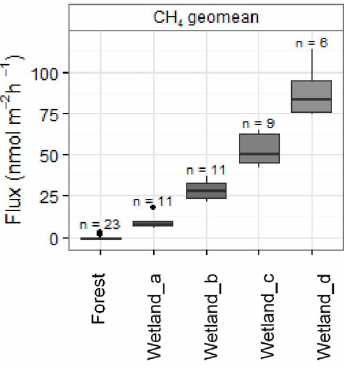
Figure 5. Chambers clustered based on emissions with n indicating the number of chambers within each group.